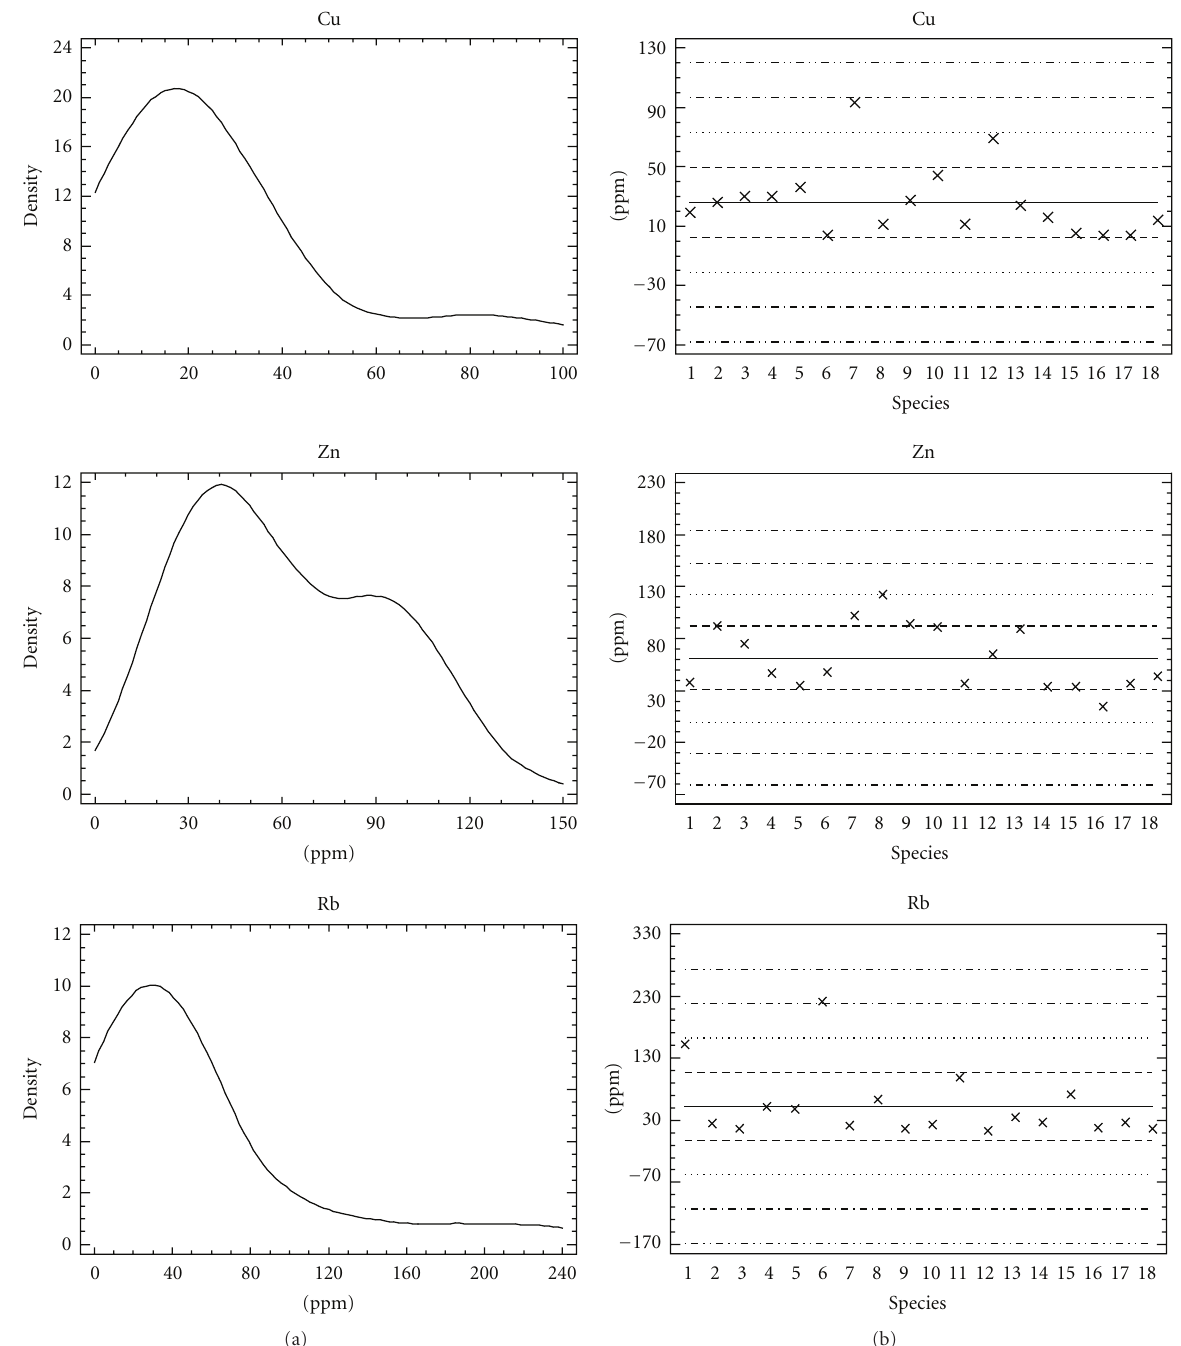
Figure 5: Nonparametrical density curves (a) and studentized values plots (b) for Cu, Zn, and Rb. The mean value is depicted by a solid line. The horizontal dashed lines are multiples of the standard deviation. The abscissa tick labels correspond to the species numbered in Table 2.